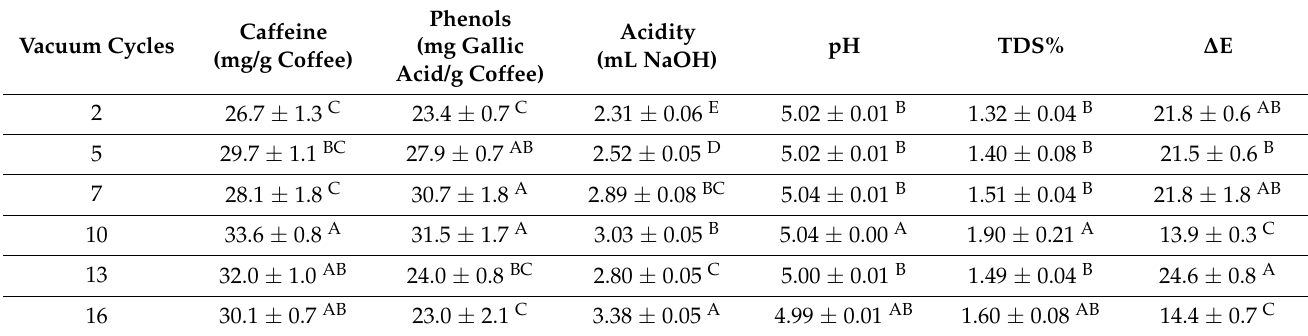
Table 3. Effect of vacuum cycles on physicochemical properties (avg ± SD, n = 3) 1,2